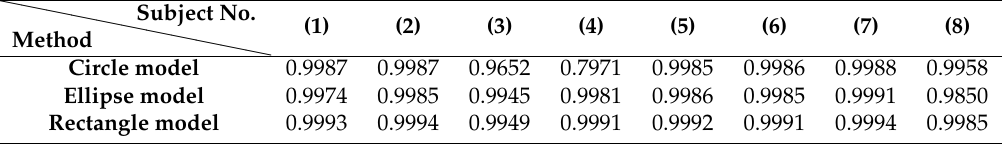
Table 3. Correlation between the AP-diameters estimated by the three shape-based algorithms and manual measurement.